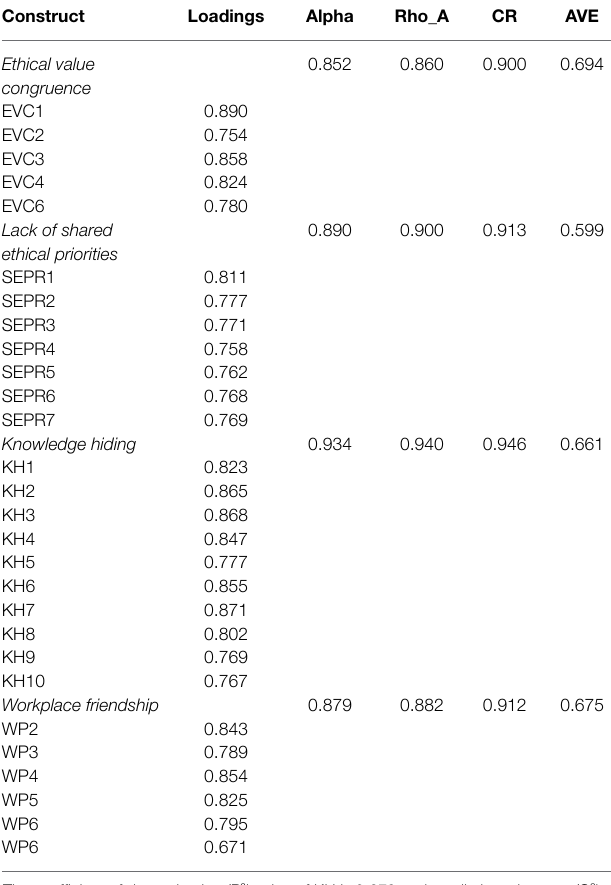
TABLE 1 | Item loadings, reliability, and convergent